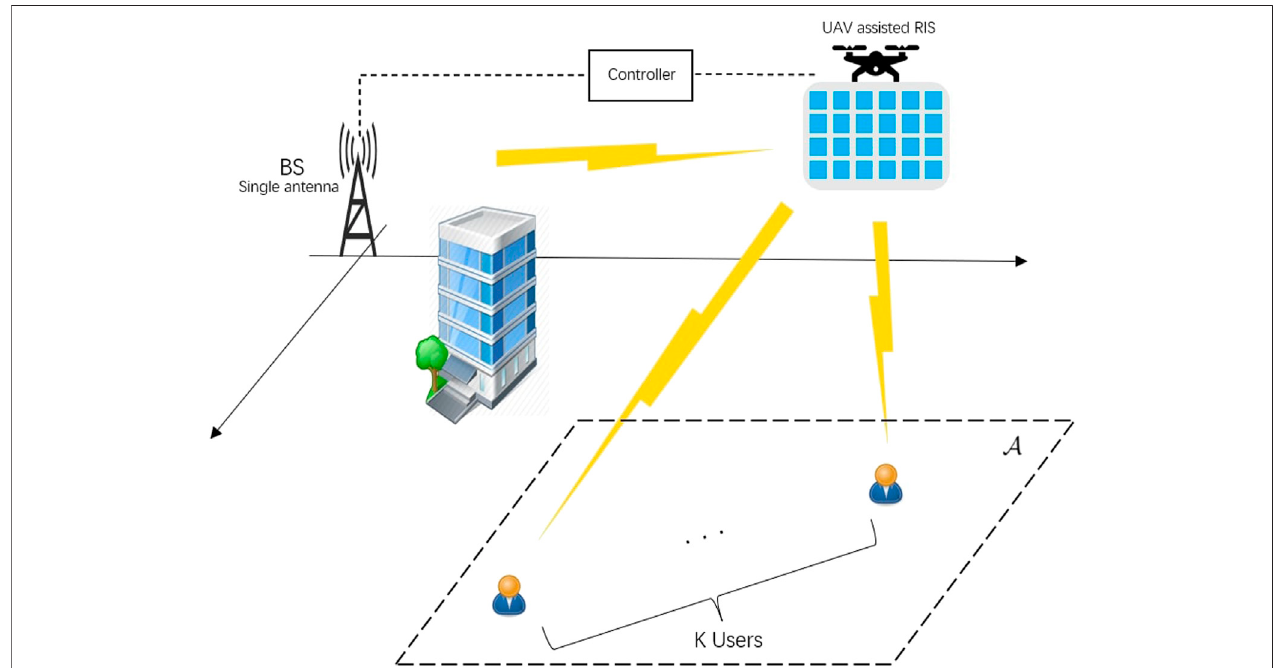
FIGURE 1 | UAV-based RIS-assisted NOMA downlink